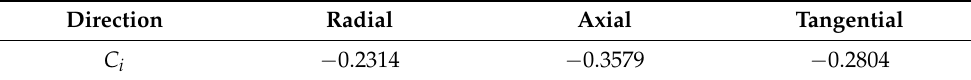
Table 2. Values of constant C i for the three directions radial, axial and tangential. Direction Radial Axial Tangential C i − 0.2314 − 0.3579 −